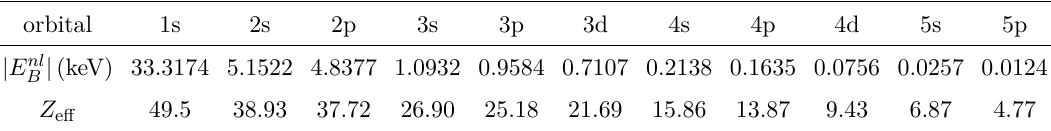
Table 1 . Binding energy and effective charge of each shell in